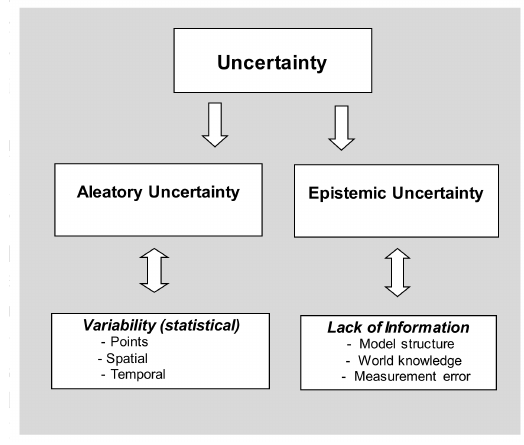
Figure 1. A taxonomy of uncertainty that shows the division between statistical variability and epistemic uncertainty.